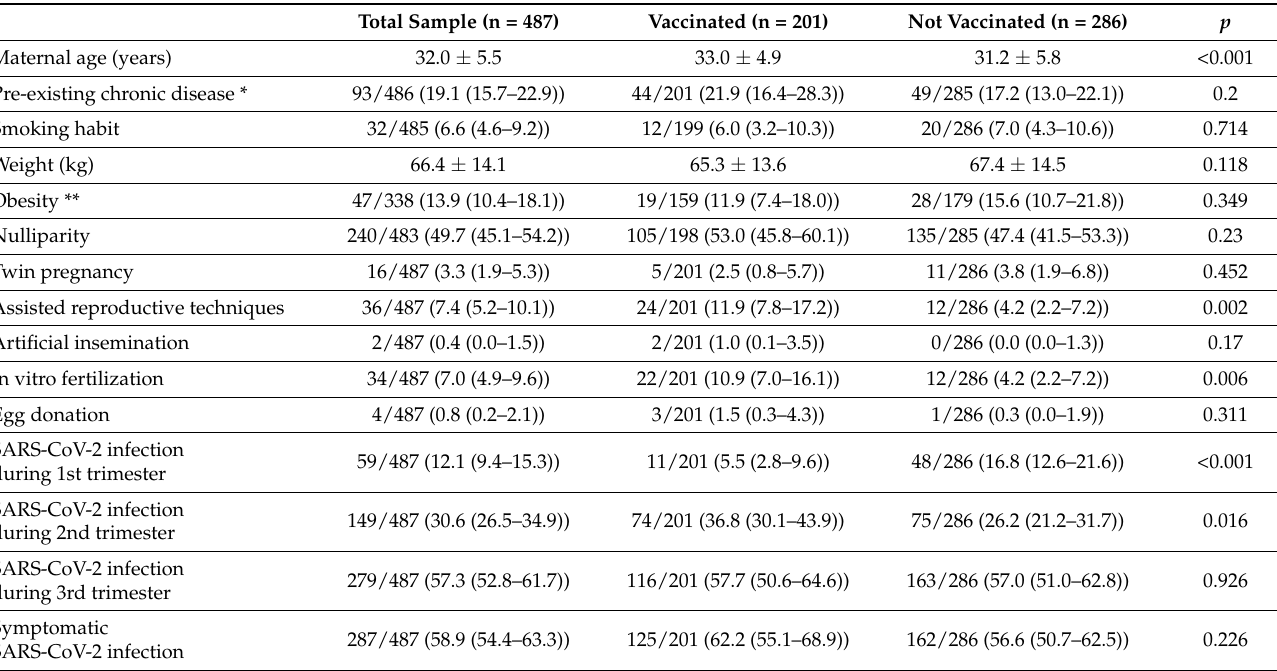
Figure 2. Timing of COVID-19 vaccination in the pregnant patients (201/487 (41.27%)) who received at least one COVID-19 vaccine before the SARS-CoV-19 infection. The number of patients that received the first, second, or third dose of a vaccine before or during the different trimesters of pregnancy is shown. Table 4. Characteristics of 487 pregnant women with SARS-CoV-2 infection, overall and according to the vaccination